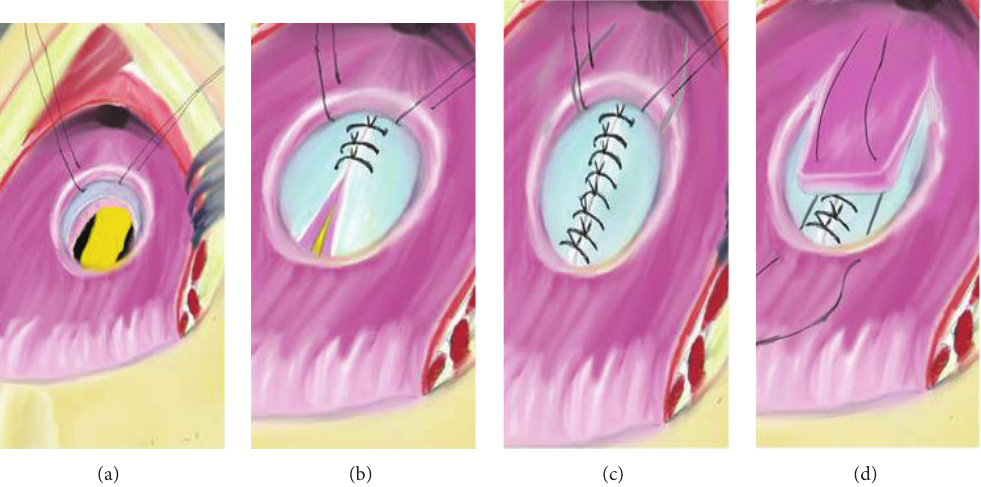
Figure 6: Schematic illustration of the picture in Figure 5 showing dissection and closure of RUF. (a) All through the anterior rectal wall and posterior urethral wall were separated by sharp dissection. (b) After separation, first closure of the urethral wall by interrupted suture is seen. (c) After finishing posterior urethral wall closure, prepared rectal advancement flap from proximal side is seen. (d) After preparing rectal advancement flap, its fixation with interrupted sutures one by one is